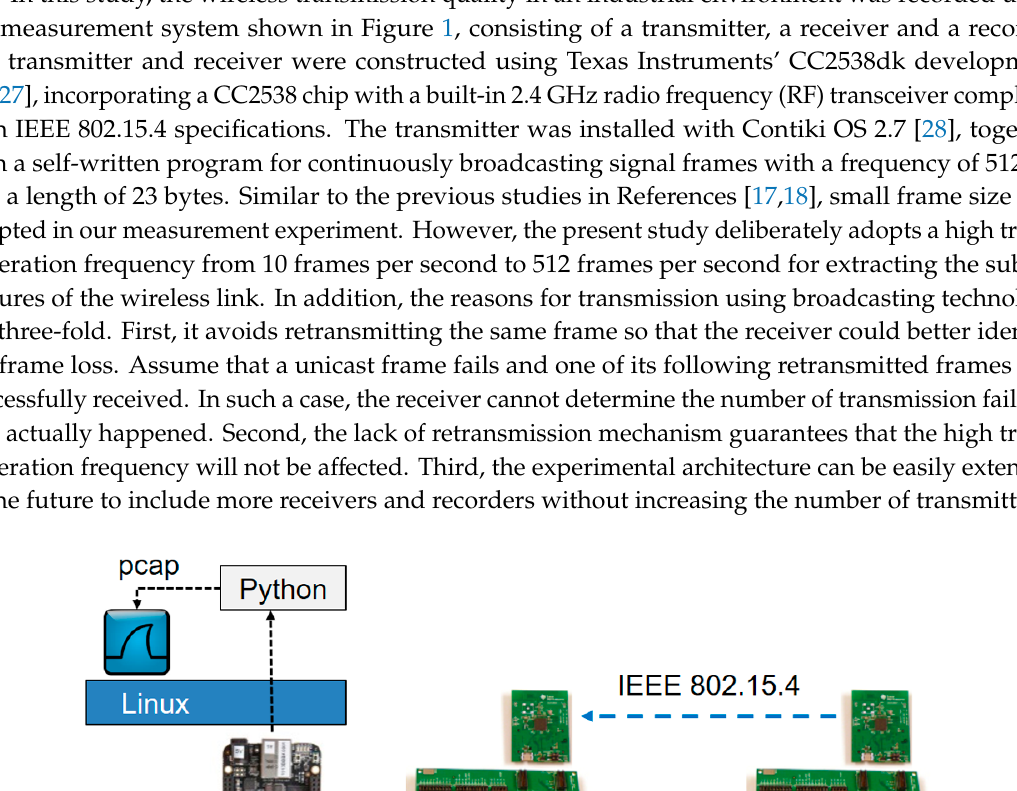
Figure 2. Format of signal frame in trace experiments.